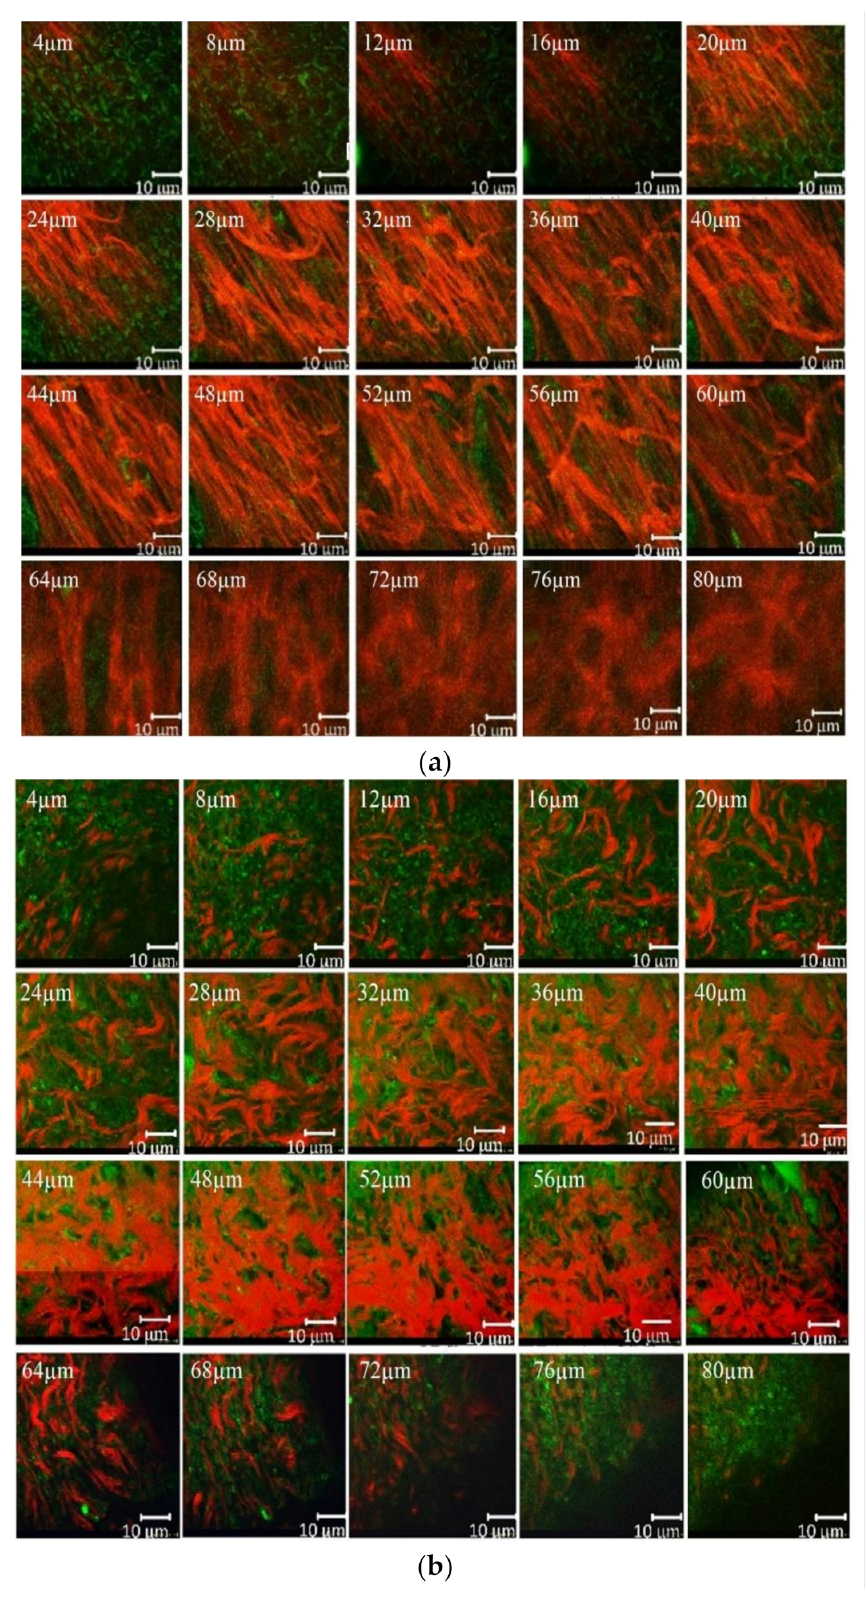
Figure 5. ( a ) SHG (red) and AF (green) of healthy skin at depths from 4 to 80 µ m; ( b ) SHG (red) and AF (green) of a wound at depths from 4 to 80 µ